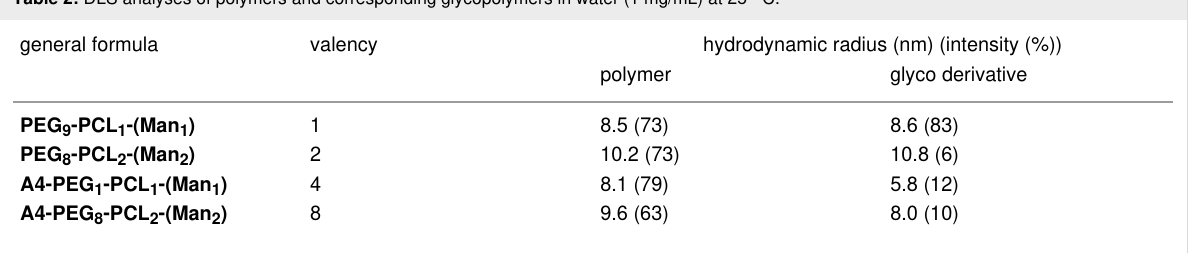
Table 2: DLS analyses of polymers and corresponding glycopolymers in water (1 mg/mL) at 25 °C. general